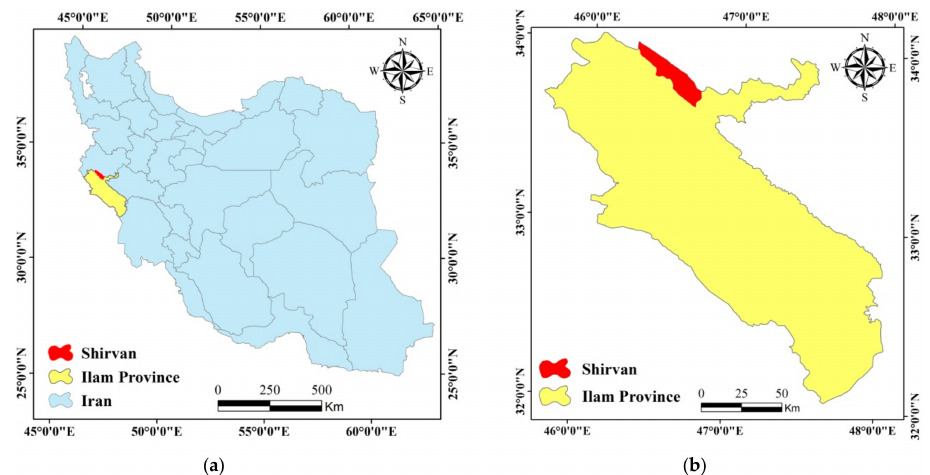
Figure 1. Location of our study area in Iran and Ilam Province. ( a ) Location of Ilam Province in Iran. ( b ) Location of Shirvan County in Ilam Province.